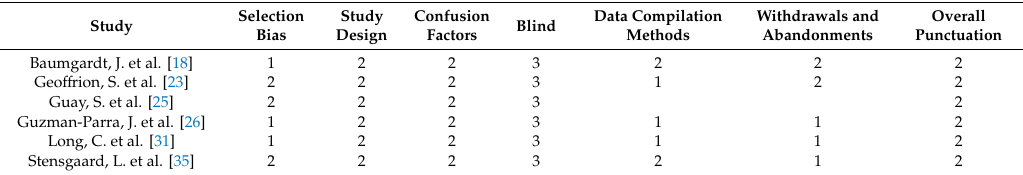
Table 6. Results of the methodological quality assessment (E ff ective Public Health Practice Project, EPHPP) [39].